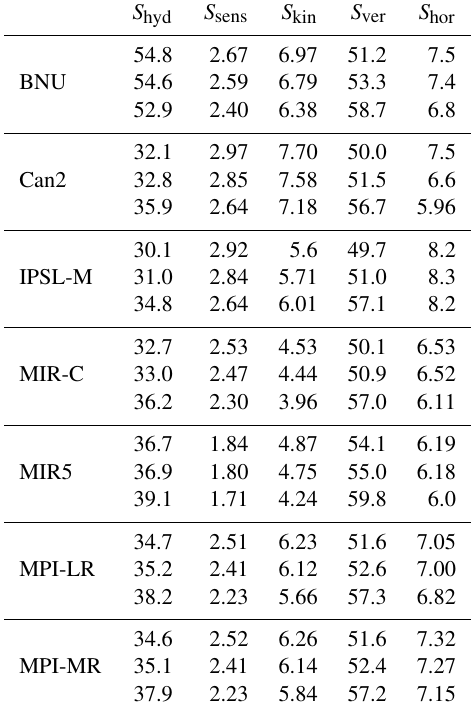
Table 8. Annual mean components of the material entropy produc- tion obtained with the direct and indirect methods. For each model, the first row denotes the estimates from piC, the second row from hist and the third row from RCP8.5 (values: mWm − 2 K − 1 ). S hyd S sens S kin S